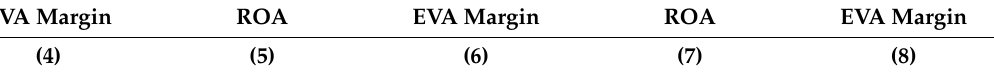
Table 4. OLS regressions: main proxies for economic